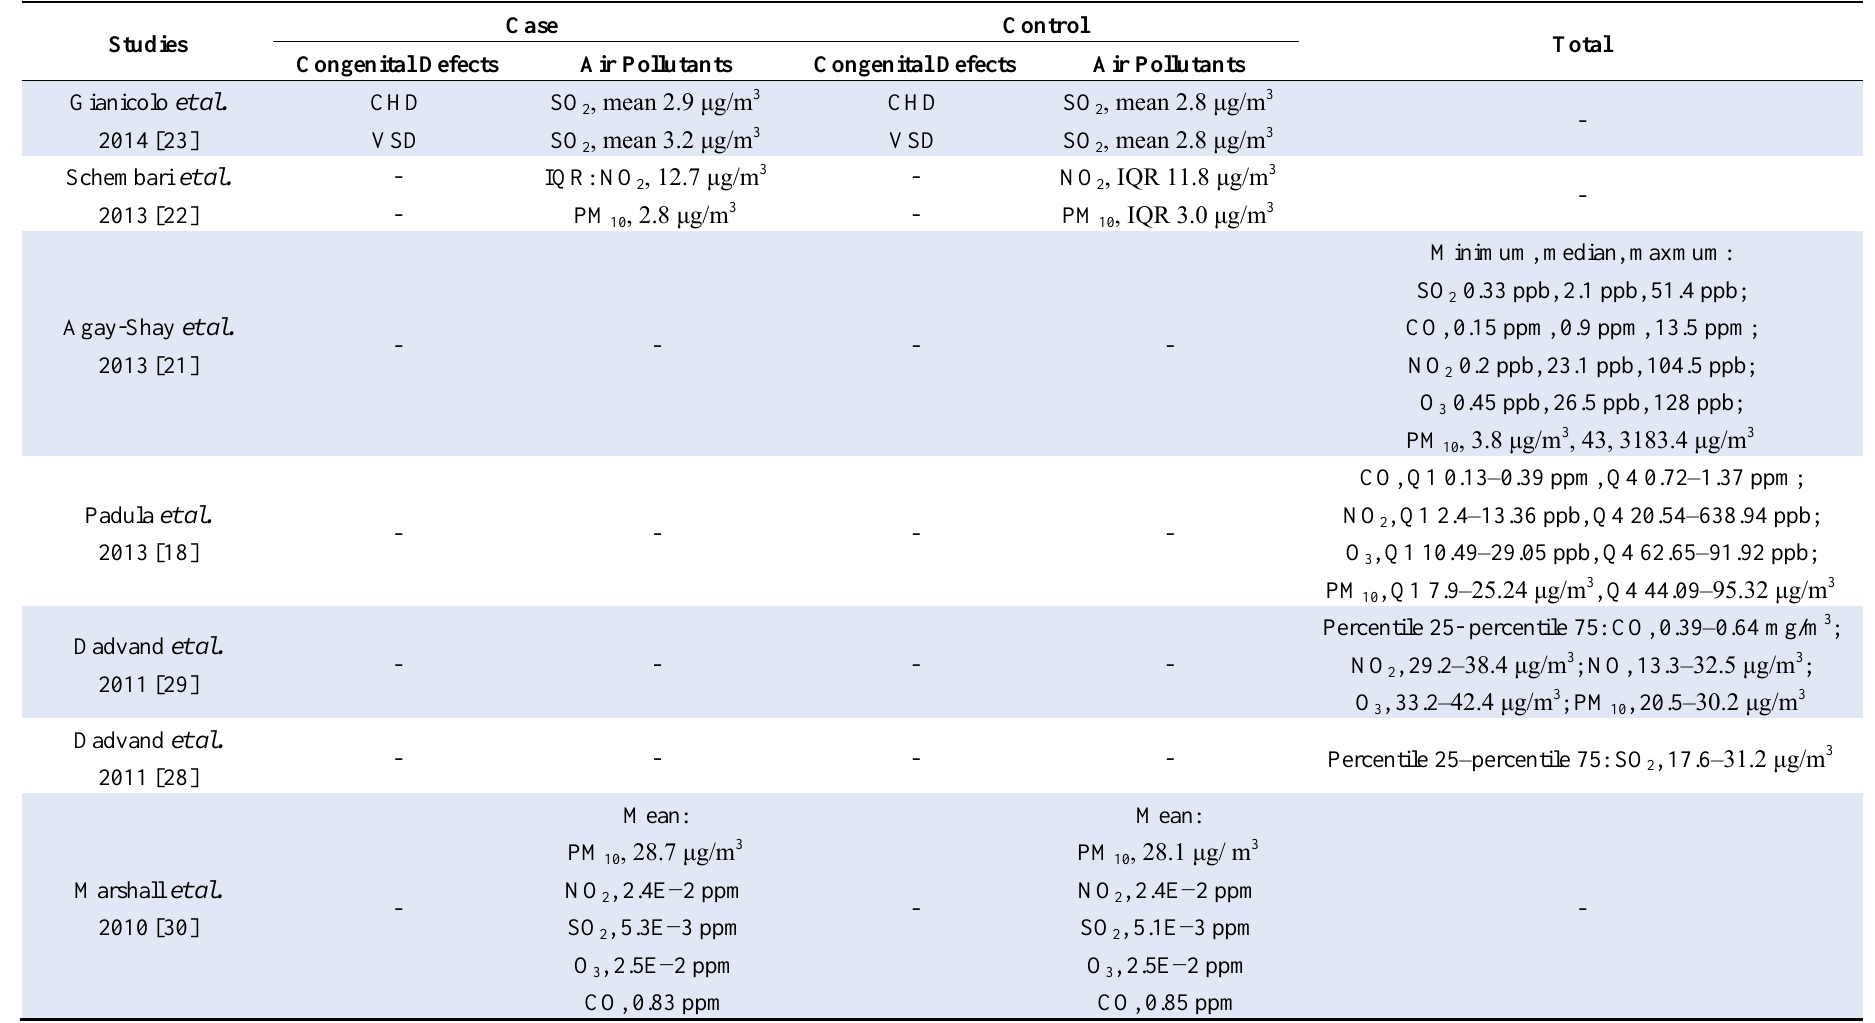
Table 2. Exposure distribution in studies included in the meta